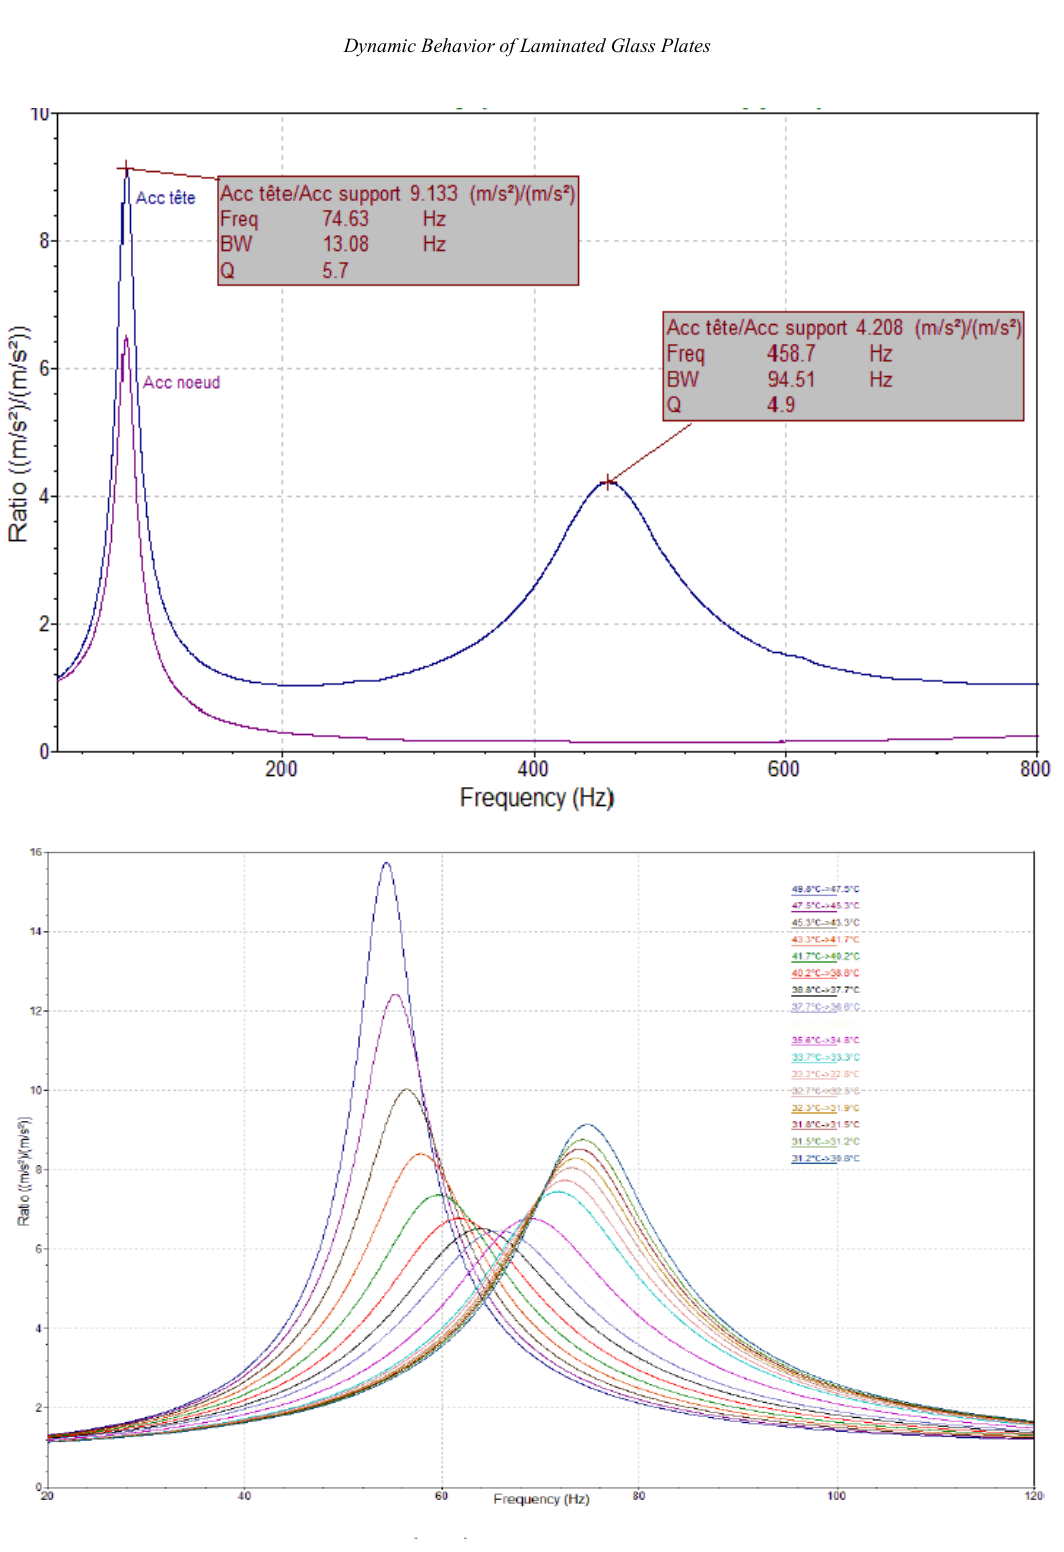
Fig. 1 Experimental transfer functions. Top : Identification of the two first eigen frequencies at a temperature of 31°C. Bottom : Identification of the fundamental frequency at different temperatures ranging from 31°C (peak at 74.5Hz) to 49.5°C (peak at 54.4Hz).